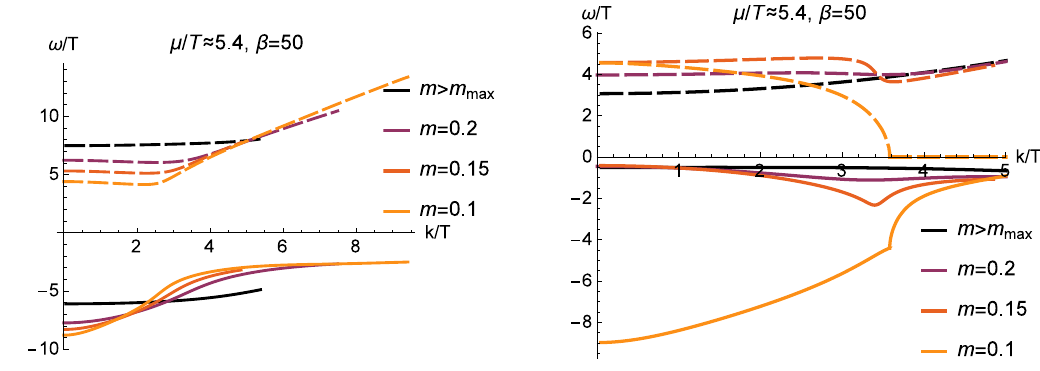
Figure 14 . The gapped QNM (left) and CM (right) at (cid:22)=T (cid:25) 5 : 4 and (cid:12) = 50.